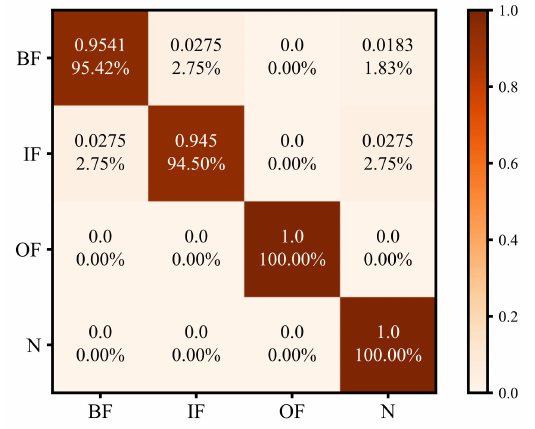
Figure 11. Confusion matrix.